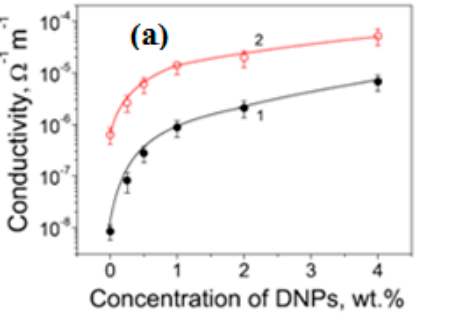
Figure 2. Variations of conductivity with concentration of diamond NPs dispersed ( a ) pure nematic E7 and ( b ) impure nematic E7. Curves 1 and 2 refer to the temperature 20 and 80 °C, respectively [41].